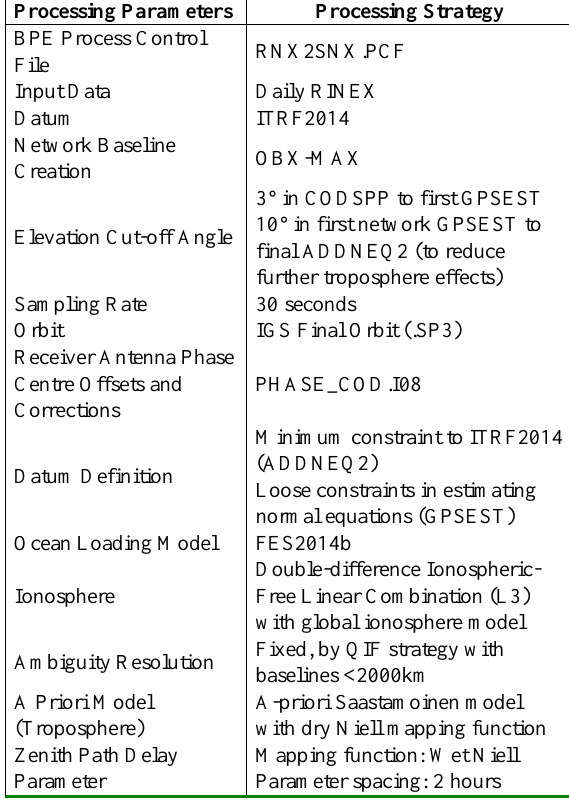
Table 1. Processing strategy and parameters adopted in Bernese